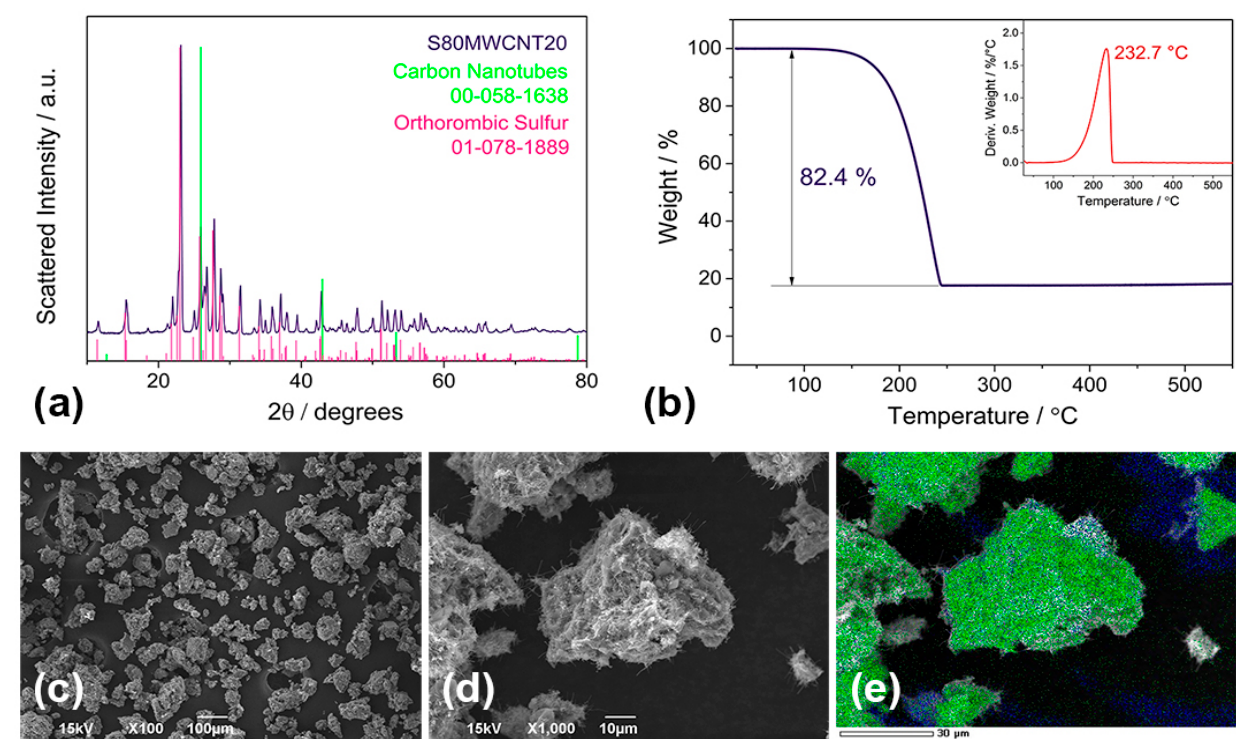
Figure 1. ( a ) X-ray diffraction pattern of the S80MWCNT20 composite (purple curve), reference patterns of bulk orthorhombic sulfur (pink bars, ICDD: 01-078-1889), and carbon nanotubes (green bars, ICDD: 00-058-1638). ( b ) Thermogravimetric analysis of the composite performed under a nitrogen atmosphere by increasing the temperature from room temperature to 600 °C at 10 °C min − 1 . ( c , d ) SEM images at different magnifications and ( e ) EDX mapping of the composite (green color for sulfur, blue color for carbon).